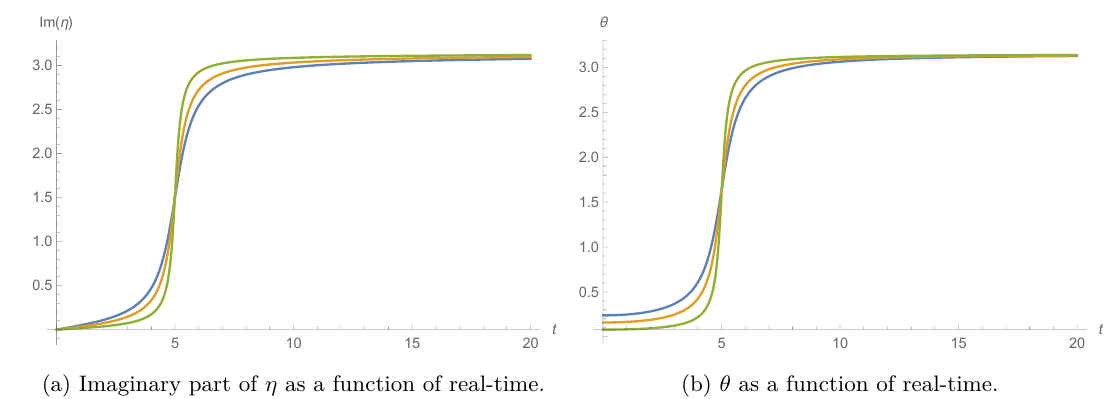
Figure 2 . We plot imaginary part of η and θ as a function of real-time by varying (cid:15) . Blue line corresponds to (cid:15) = 0 . 6 , orange line corresponds to (cid:15) = 0 . 4 , and green line corresponds to (cid:15) = 0 . 2 . We keep y 0 = − 5 in all